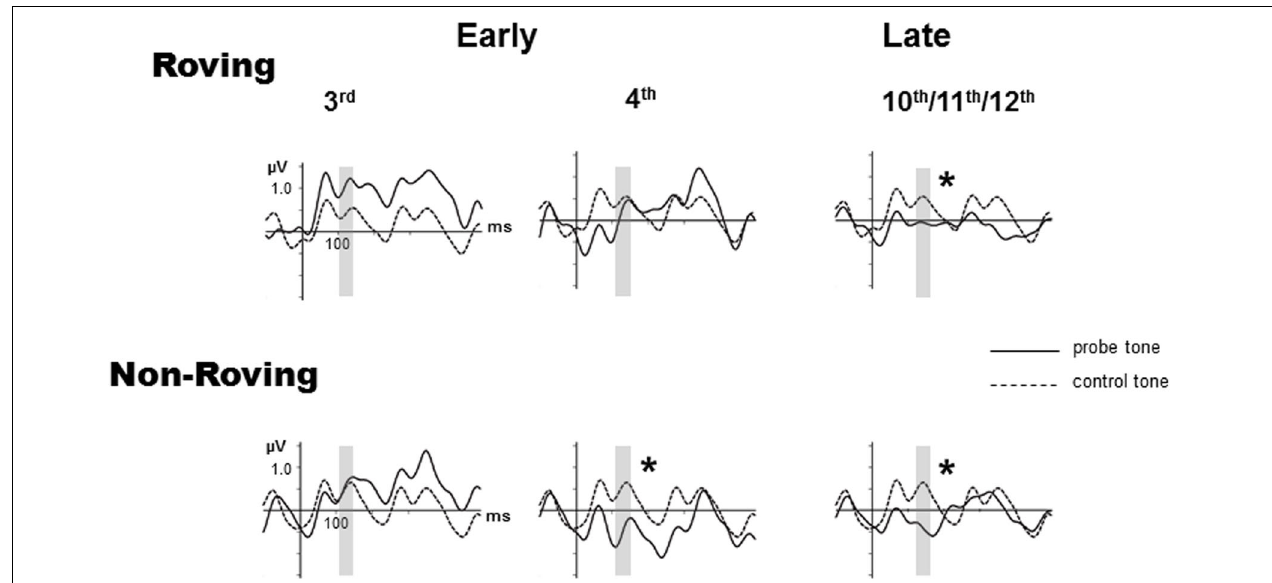
FIGURE 2 | Grand-averaged event-related potentials (ERPs) evoked by probe tones (solid line) and control tones (dashed line) are overlain at the Fz electrode for the early 3rd position tone (left column), early 4th position tone (middle column), and the late position tone, which is the average of the 10–12th tones (right column), separately for the